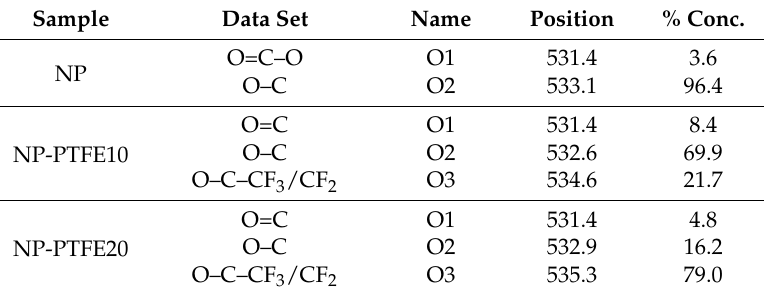
Table 4. O 1s peak fitting result for NP, NP-PTFE10, and NP-PTFE20.